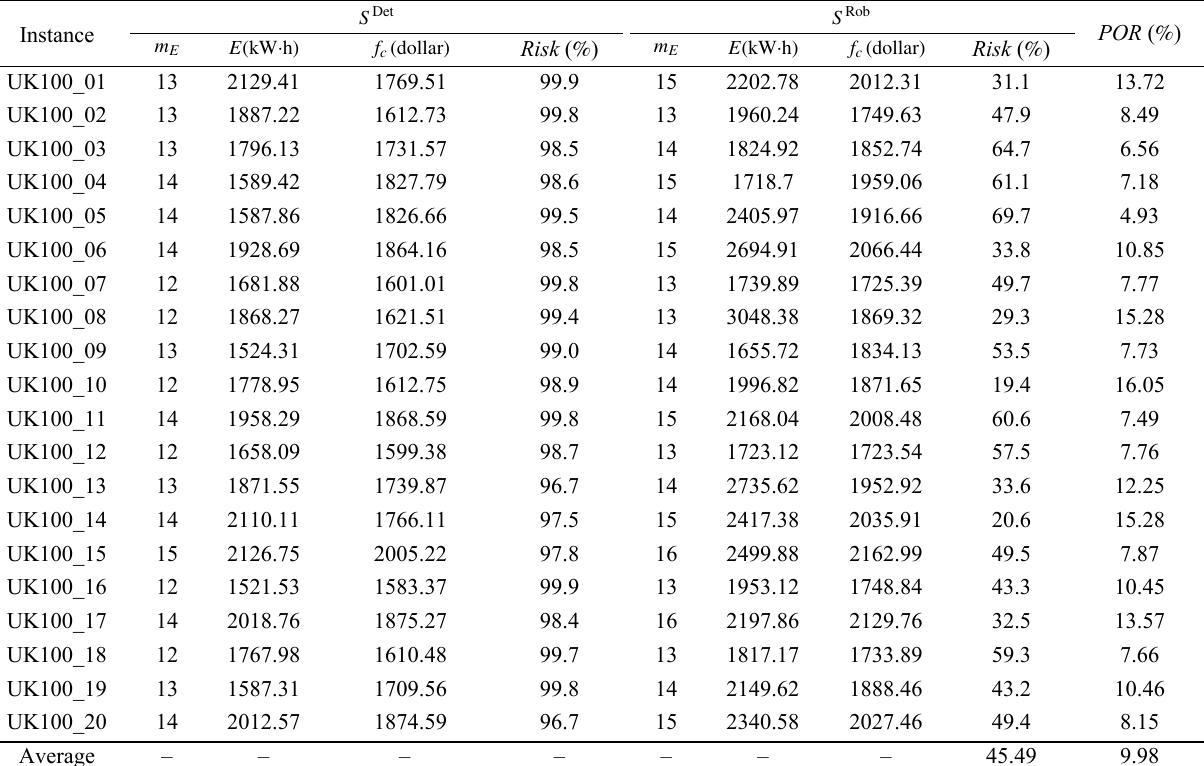
Table 4 Comparison on solutions of the EVRPTW in deterministic customer